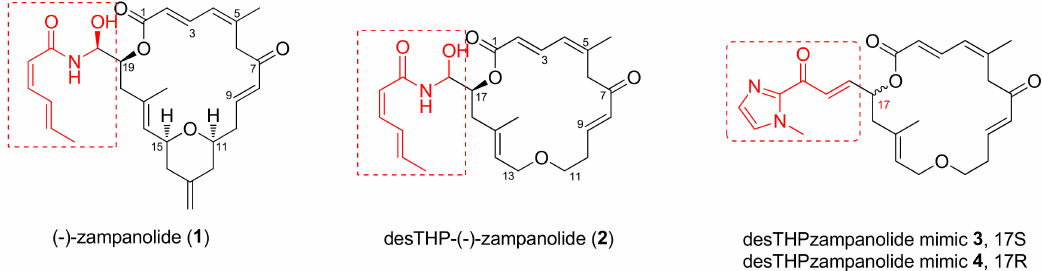
Figure 1. Zampanolide, desTHP-( − )-zampanolide, desTHPzampanolide mimics 3 and 4